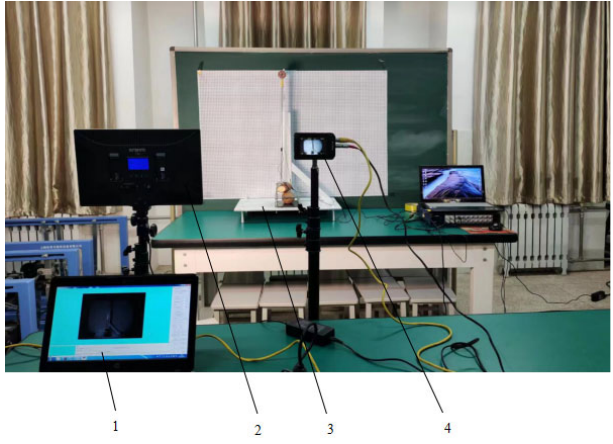
Figure 2. Friction image acquisition system. 1. Computer. 2. Flat panel light supplement. 3. Single pendulum friction test device. 4. High ‐ speed digital camera. pendulum friction test device. 4. High-speed digital